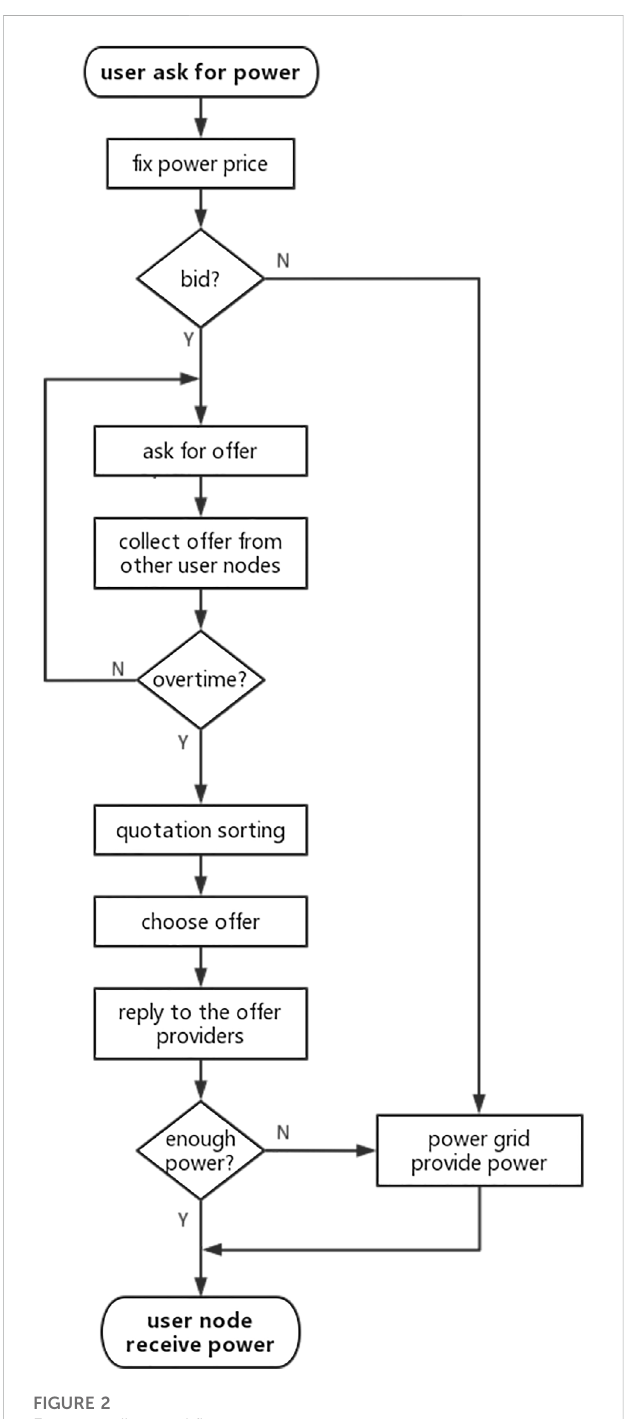
FIGURE 2 Energy trading work fl